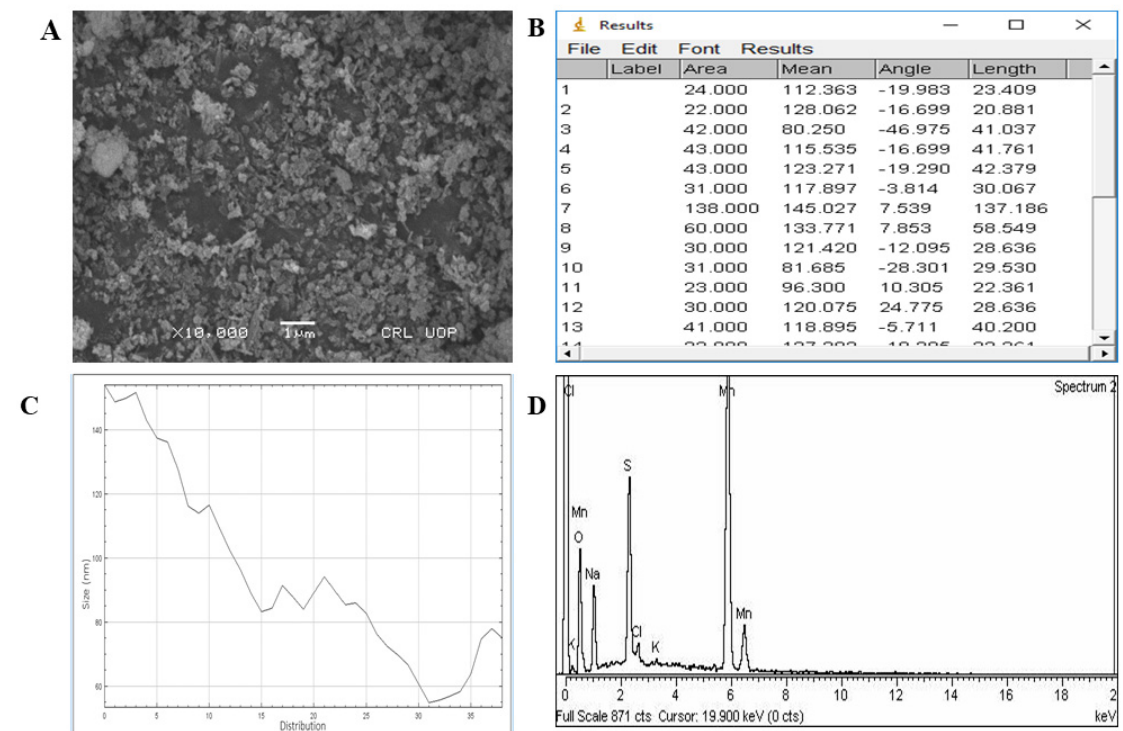
Figure 3. ( A ) Scanning electron microscopy (SEM), ( B ) image J analysis of SEM image, ( C ) size distribution, and ( D ) energy-dispersive X-ray (EDX) for the green synthesized MnO 2 NPs.